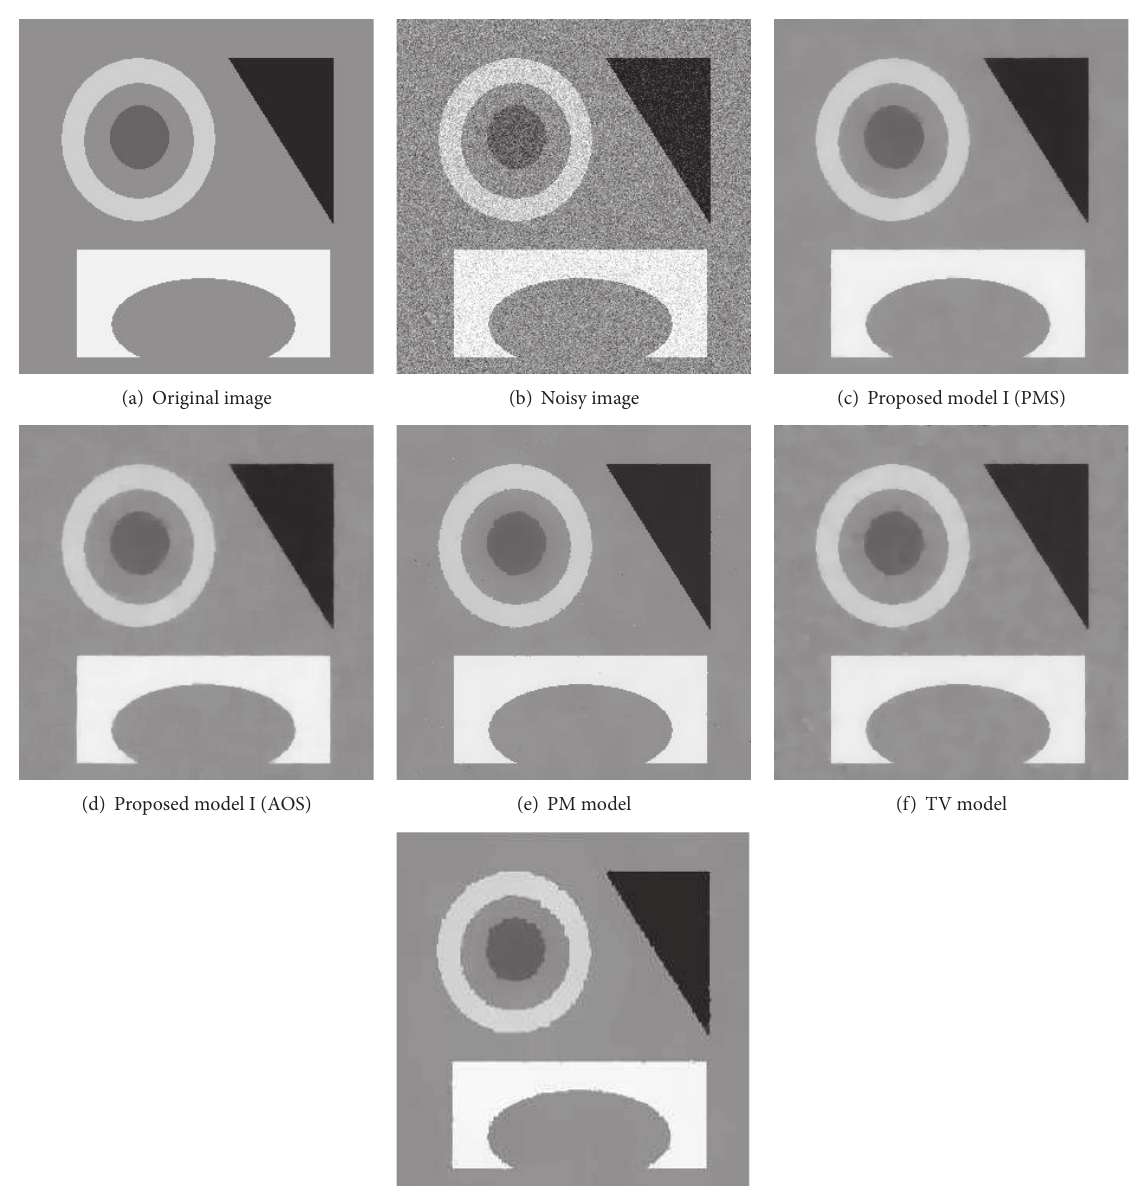
Figure 1: Synthetic image ( 300 × 300 ). (a) Original image. (b) Noisy image corrupted by Gaussian noise for 𝜎 = 30 . (c) Our algorithm by PMS; 𝜏 = 0.2 (262 steps). (d) Our algorithm by AOS scheme; 𝜏 = 3 (17 steps). (e) PM method; 𝐾 = 5 and 𝜏 = 0.25 (232 steps). (f) TV method; = 0.5 , 𝜎 = 30 , 𝜏 = 0.25 , and 𝐾 = 1 (42 𝜏 = 0.2 (203 steps). (g) D- 𝛼 -PM method; 𝜎 1